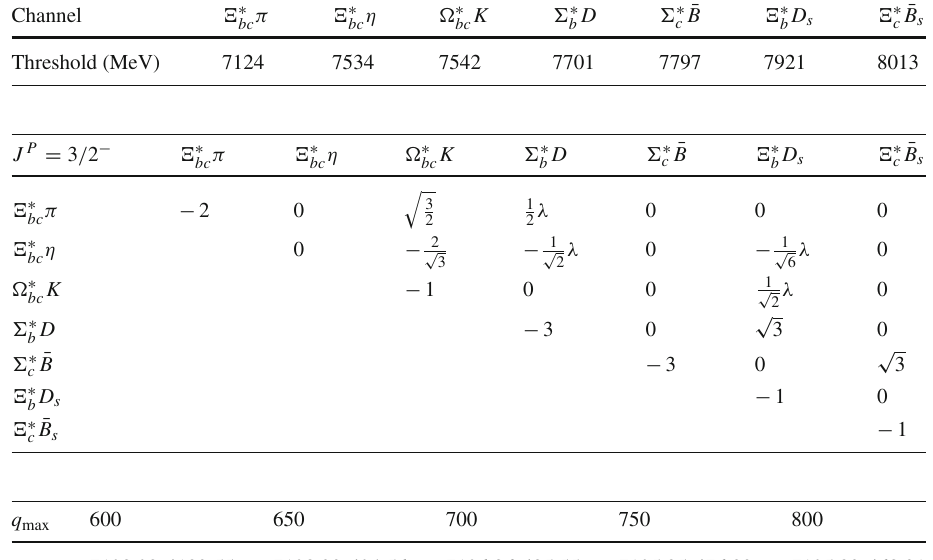
Table 32 Coupling constants to various channels and g i G II MeV with q max = 650MeV